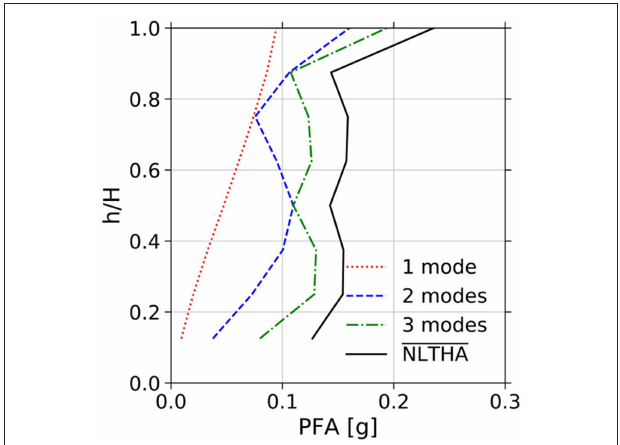
FIGURE 5 | Comparison of PFAs for a 8-story steel MRF.